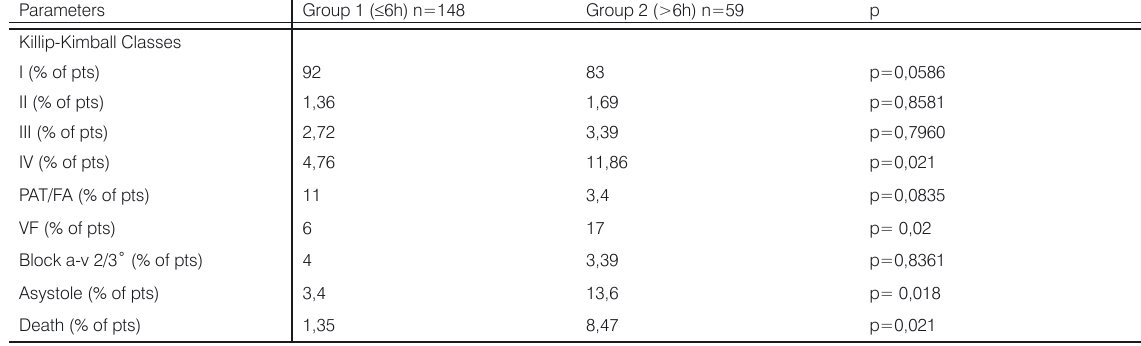
PAT - paroxysmal atrial tachycardia FA - atrial fibrillation VF - ventricular fibrillation Figure 1. Survival of patients with STE-ACS.